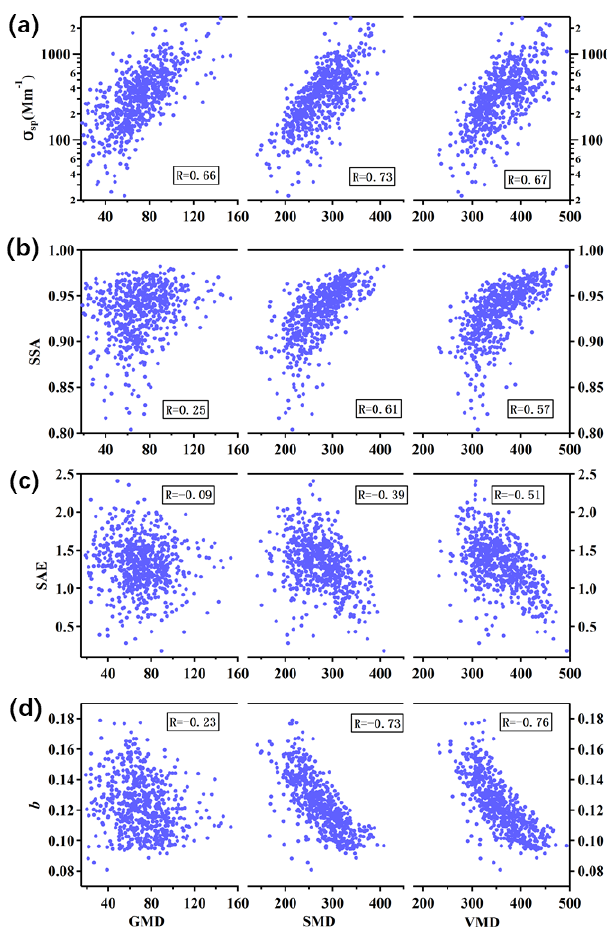
Figure 10. Relationships between (a) scattering coefficient at λ = 525nm, (b) SSA at λ = 525nm, (c) Ångström exponent of scat- tering (SAE), and (d) backscatter fraction at λ = 525nm and the effective mean diameters GMD, SMD, and VMD. The correlation coefficients are those obtained from linear